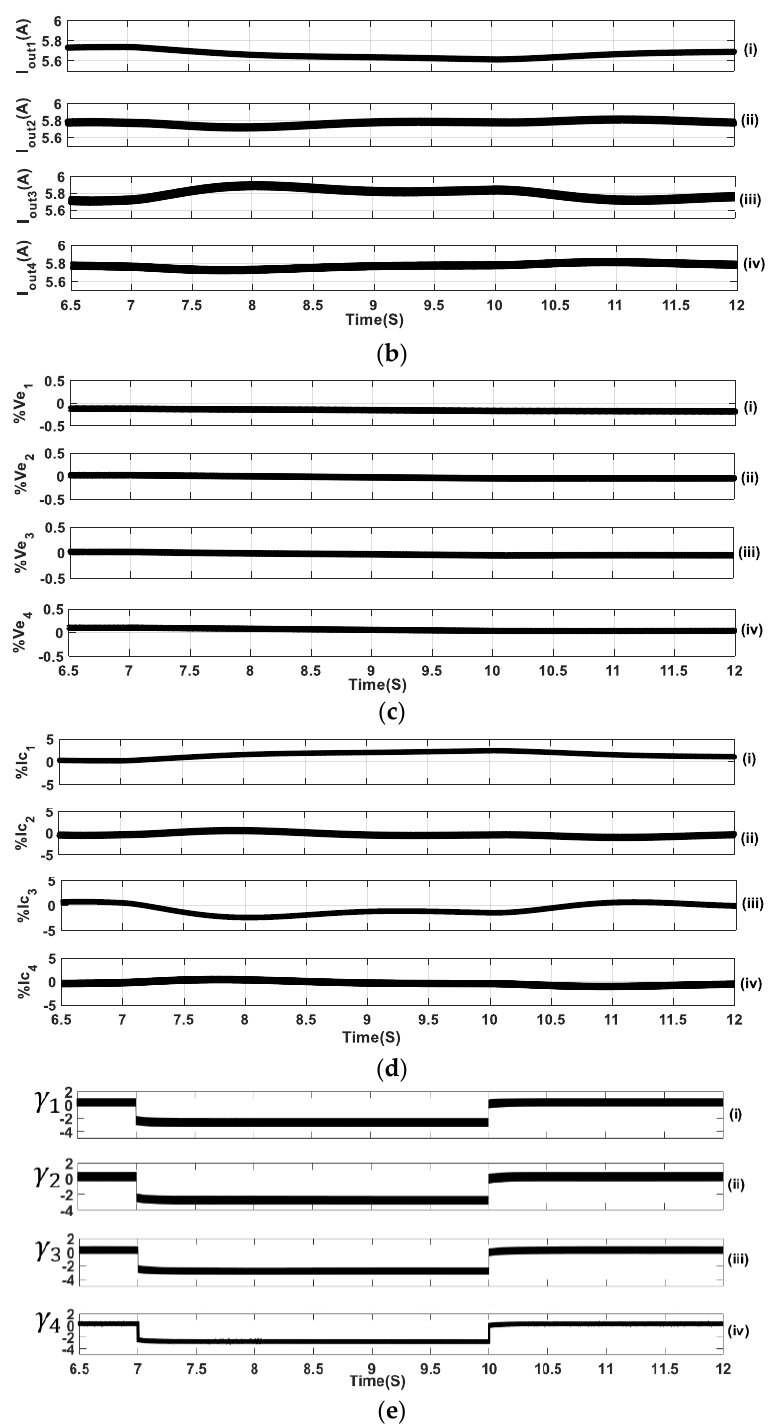
Figure 12. Third case study: ( a ) 𝑣 𝑖 , ( b ) 𝐼 𝑜𝑢𝑡 𝑖 , ( c ) %𝑉𝑒 𝑖 , ( d ) %𝐼𝑐 𝑖 , and ( e ) current cyber-attack mitigation signals for DGUs, 𝛾 i .